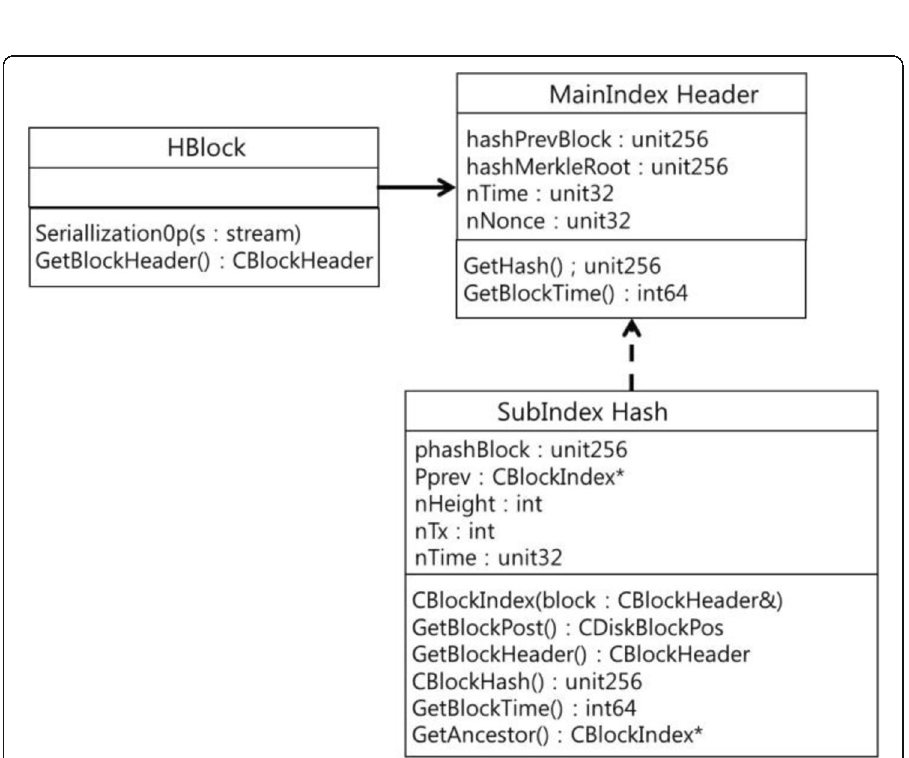
Fig. 14 UML diagram of House Rental dApp Image Application